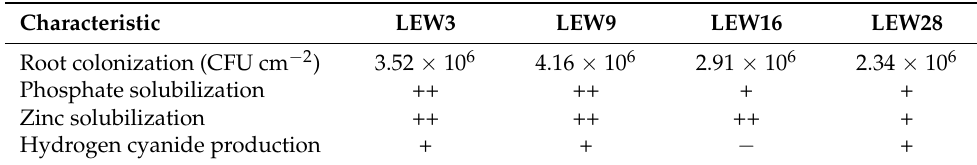
Table 4. Plant growth-promoting attributes and MIC of PEG-6000 for selected rhizobacterial strains. Characteristic LEW3 LEW9 LEW16 LEW28 Root colonization (CFU cm − 2 ) 3.52 × 10